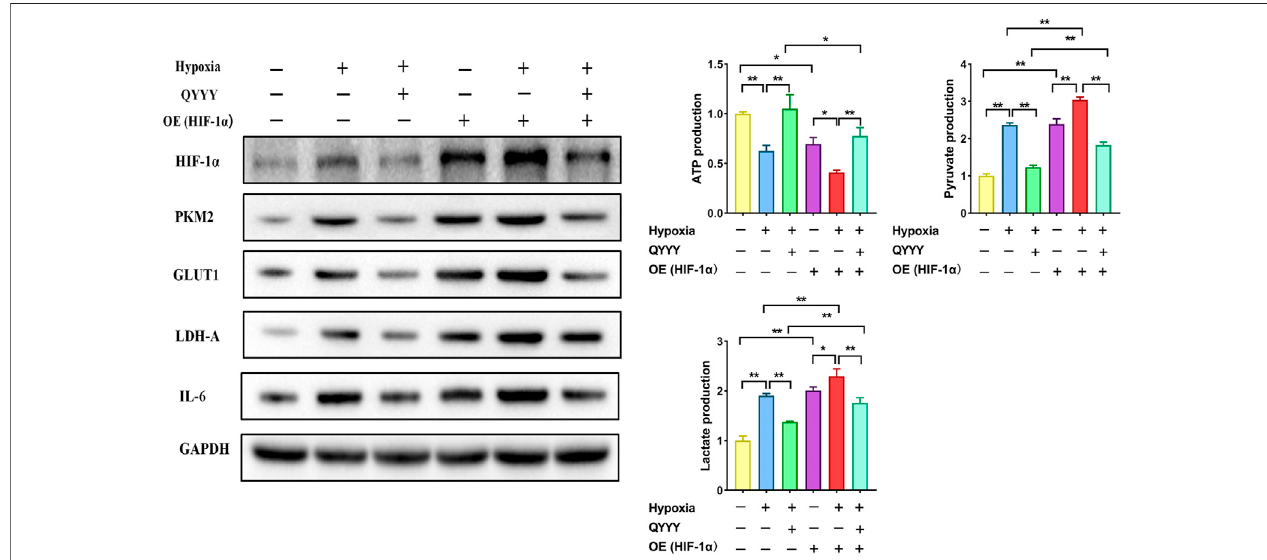
FIGURE 7 | Rescue assays certify HIF-1 α as a target of QYYY in hypertensive nephropathy. Over-expression of HIF-1 α partially abolished the effects of QYYY on hypertensive nephropathy. * p < 0.05 and ** p < 0.01.